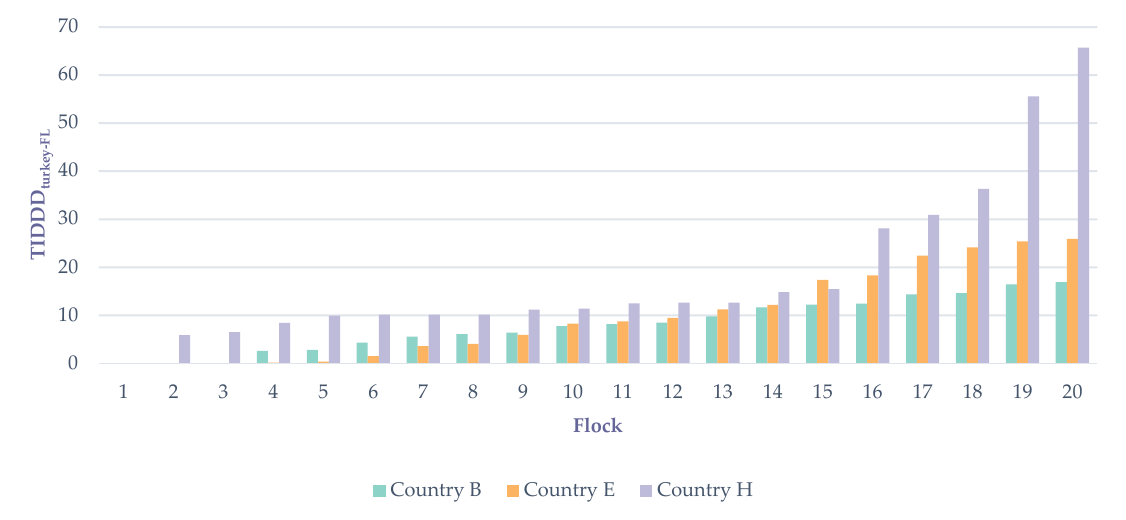
Figure 2. Antimicrobial usage of each of the 20 turkey flocks/country expressed as treatment incidence (TI) at flock level (FL): shown for TI based on DDD turkey and summed up at flock level (TIDDD turkey -FL).